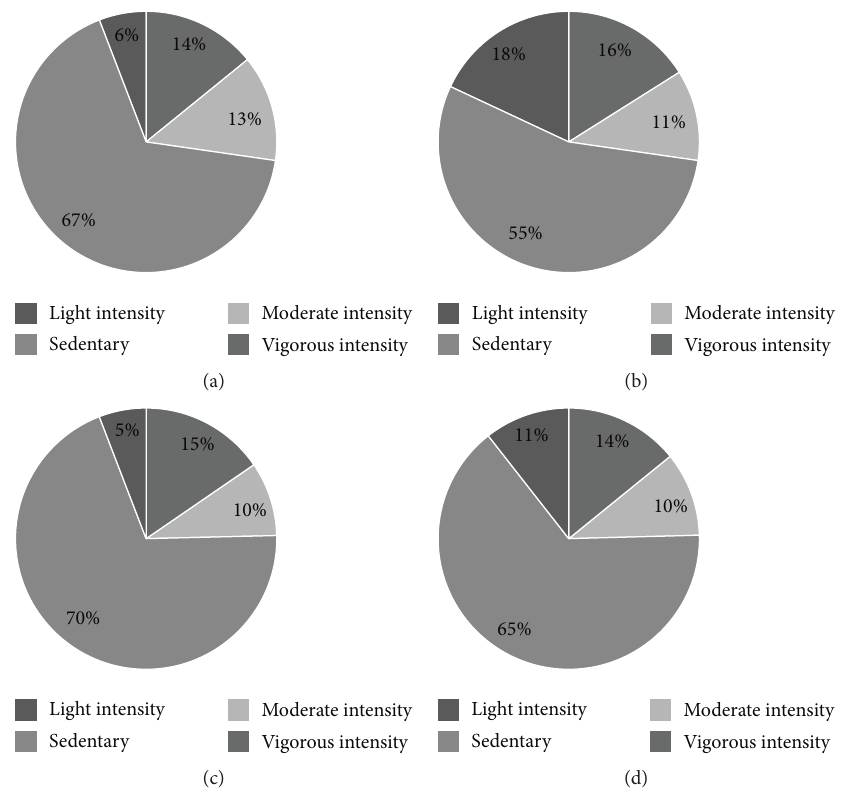
Figure 4: Change in physical activity pro fi le after intervention. Showing physical activity pro fi le. (a) Preintervention in intervention group ( n , 85). (b) Postintervention in the intervention group ( n , 80) (c) Preintervention in the control group ( n , 85). (d) Postintervention in the control group ( n , 80).